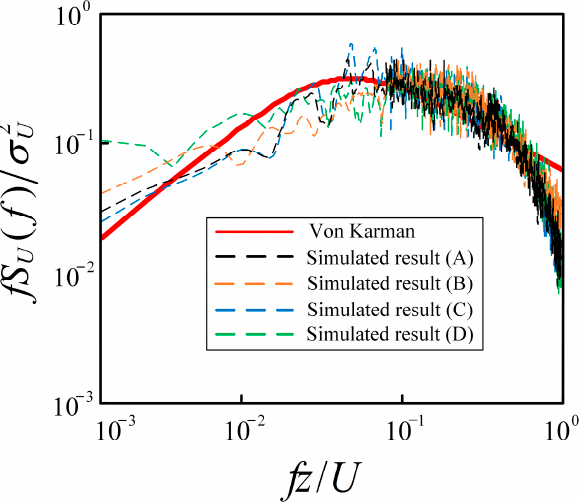
Figure 10. Comparisons of the power spectrums of fluctuating wind velocities for different terrains.